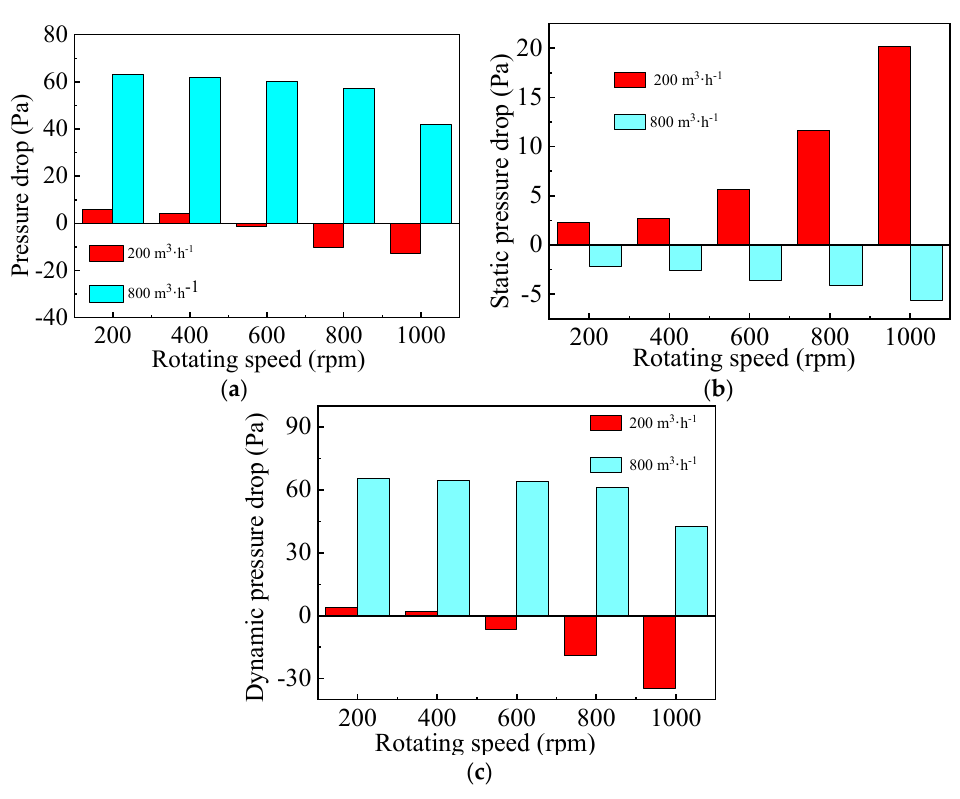
Figure 5. The effect of rotating speed on the pressure drop in cavity zone A. ( a ) Pressure drop; ( b ) static pressure drop; ( c ) dynamic pressure drop.